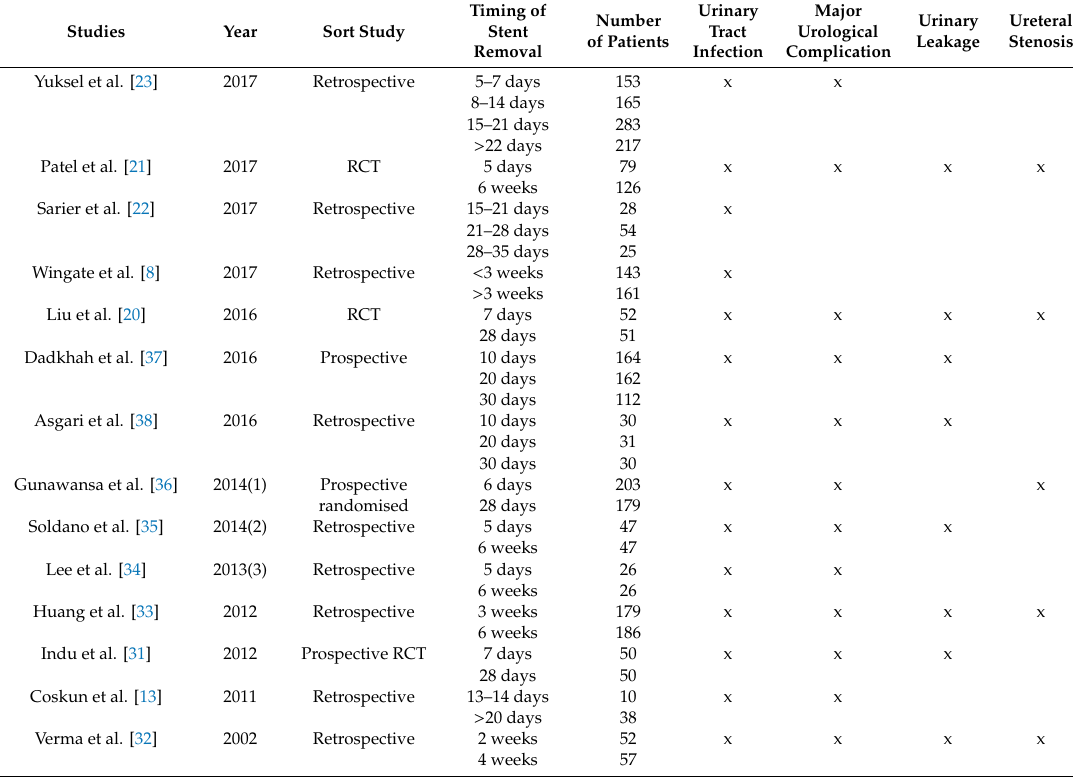
RCT:Randomisedcontrolledtrial. (1)Abstractofthe17thCongressoftheEuropeanSocietyforOrganTransplantation; (2) Abstract of the the World Transplant Congress 2014; and (3) Abstract of the 16th Congress of the European Society for Organ